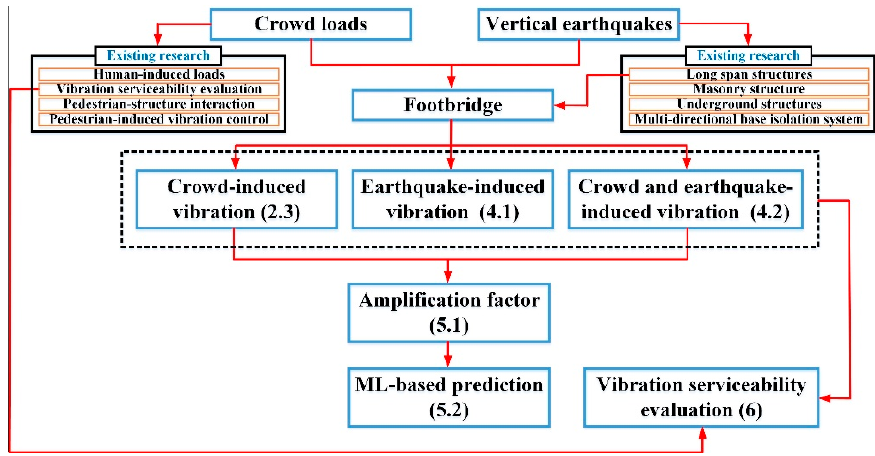
Figure 1. Driving ideas traced from the literature review and organization of the paper.